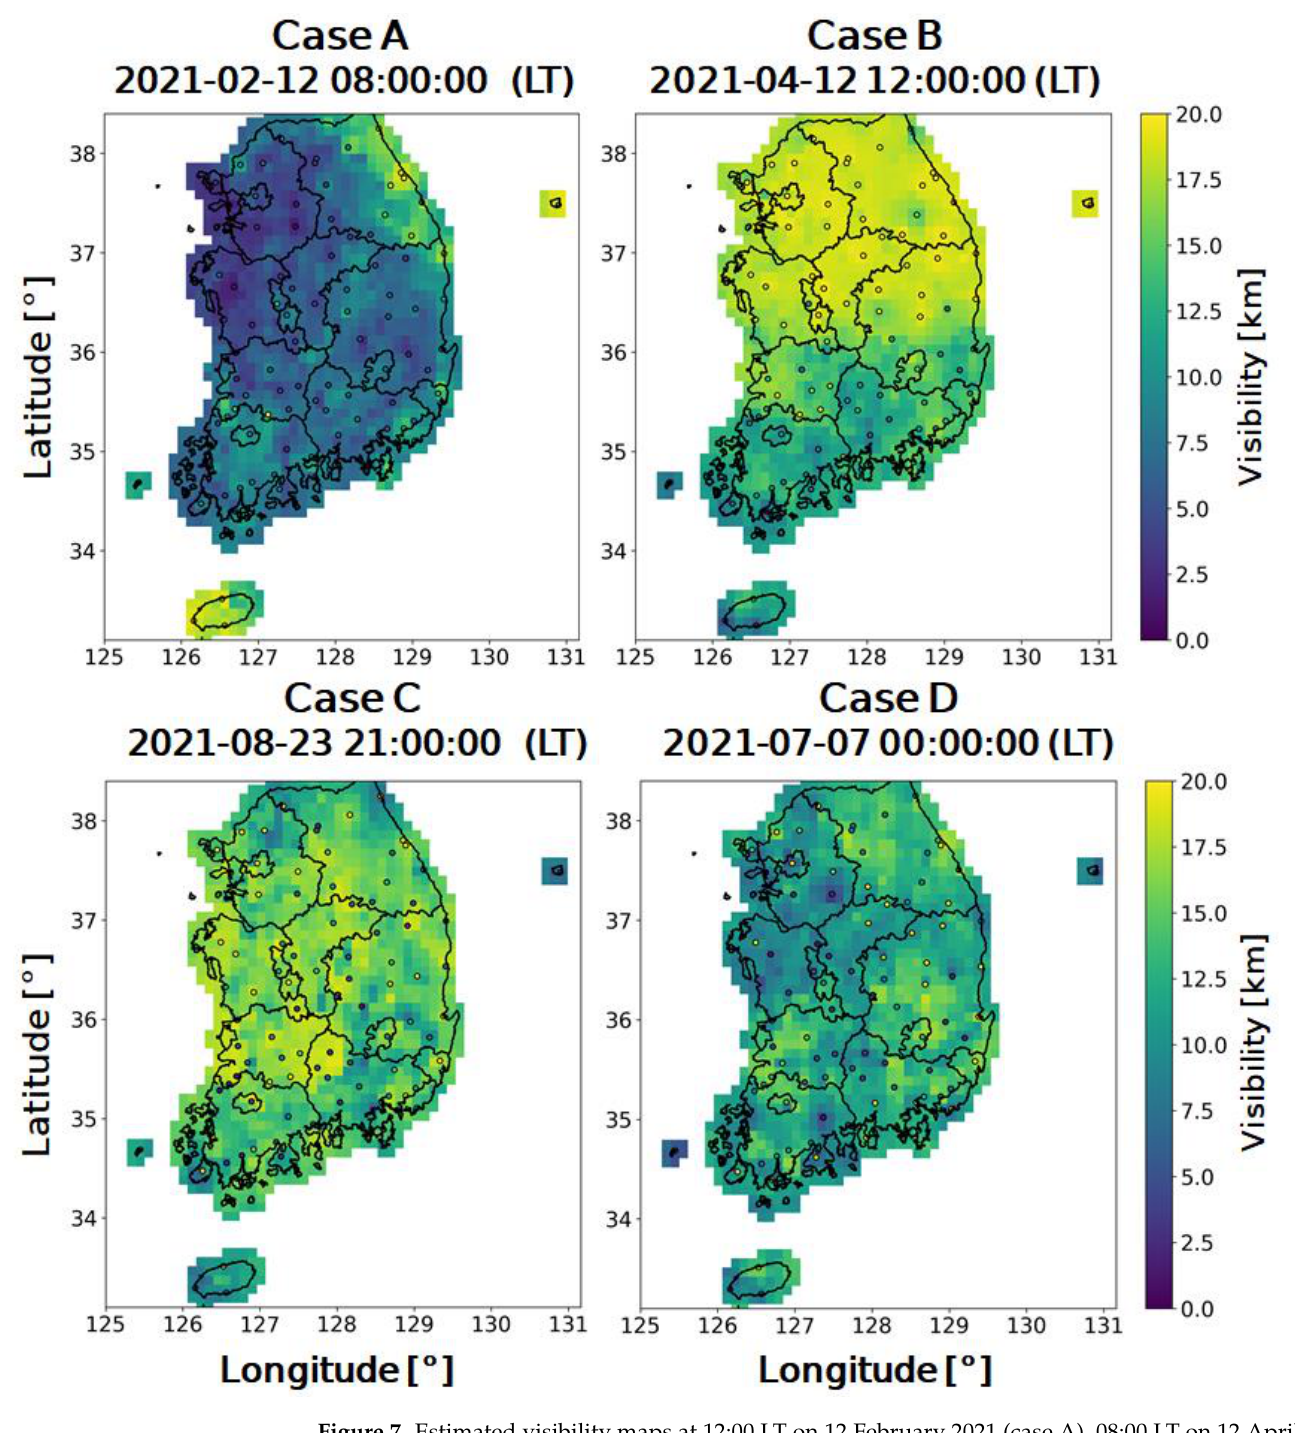
Figure 7. Estimated visibility maps at 12:00 LT on 12 February 2021 (case A), 08:00 LT on 12 April 2021 (case B), 21:00 LT on 23 August 2021 (case C), and 00:00 LT on 7 July 2021 (case D). The circle symbols indicate observed visibilities from ASOS at the same times.